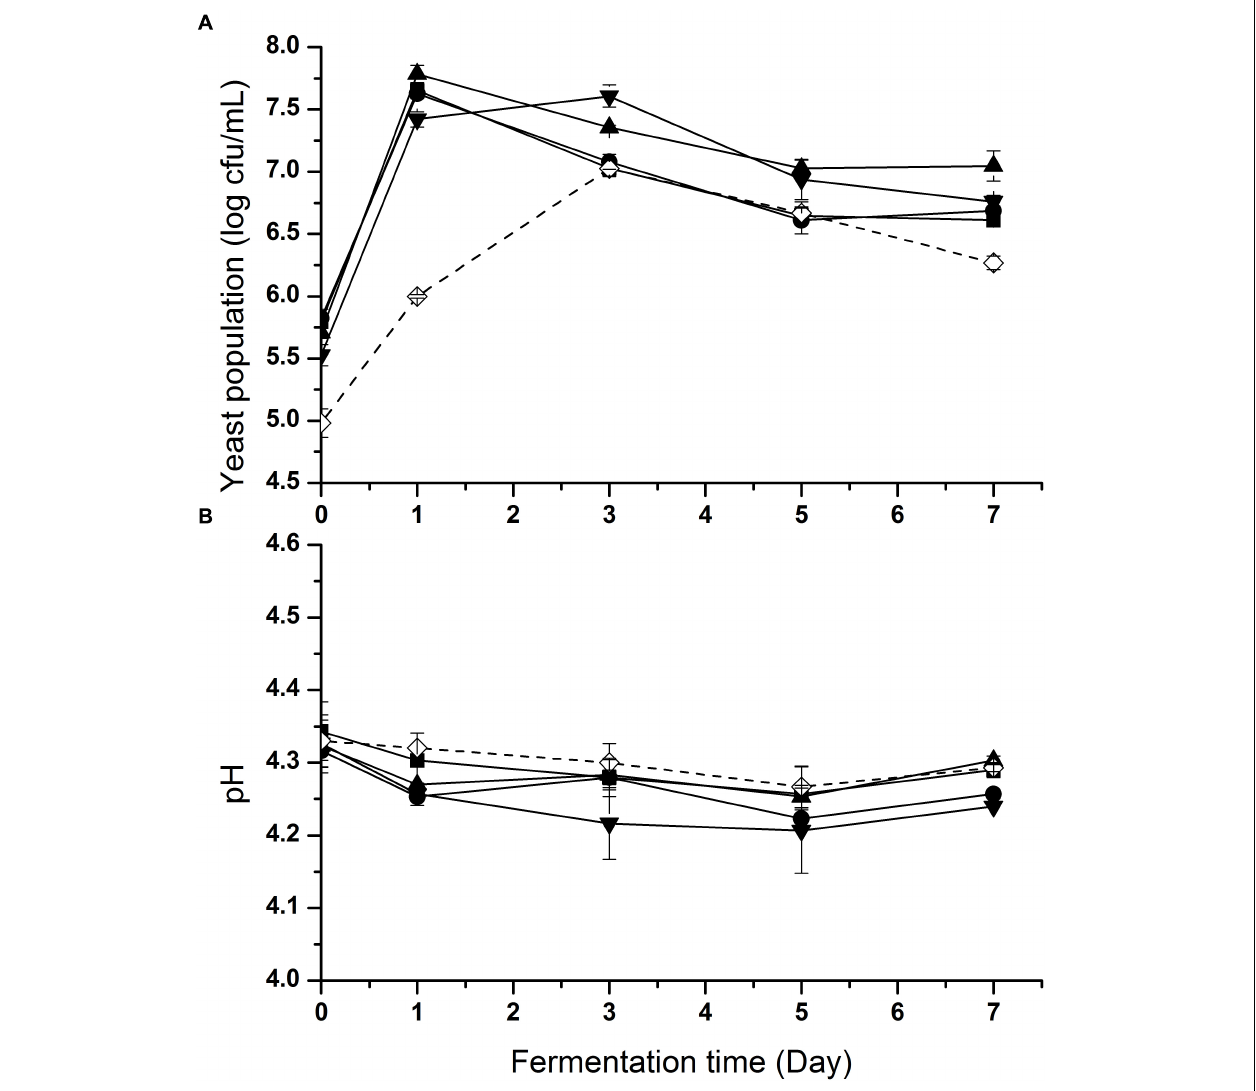
FIGURE 2 | Yeast population (A) and pH (B) changes of fish sauce during fermentation with different yeasts. S1 ( (cid:4) ): inoculated with Kluyveromyces marxianus NCYC1425; S2 ( ): inoculated with Torulaspora delbrueckii Biodiva; S3 ( (cid:78) ): inoculated with Saccharomyces cerevisiae Lalvin EC-1118; S4 ( (cid:72) ): inoculated with Pichia kluyveri Frootzen; S5 ( ♦ ): inoculated with Candida versatilis (cid:32)